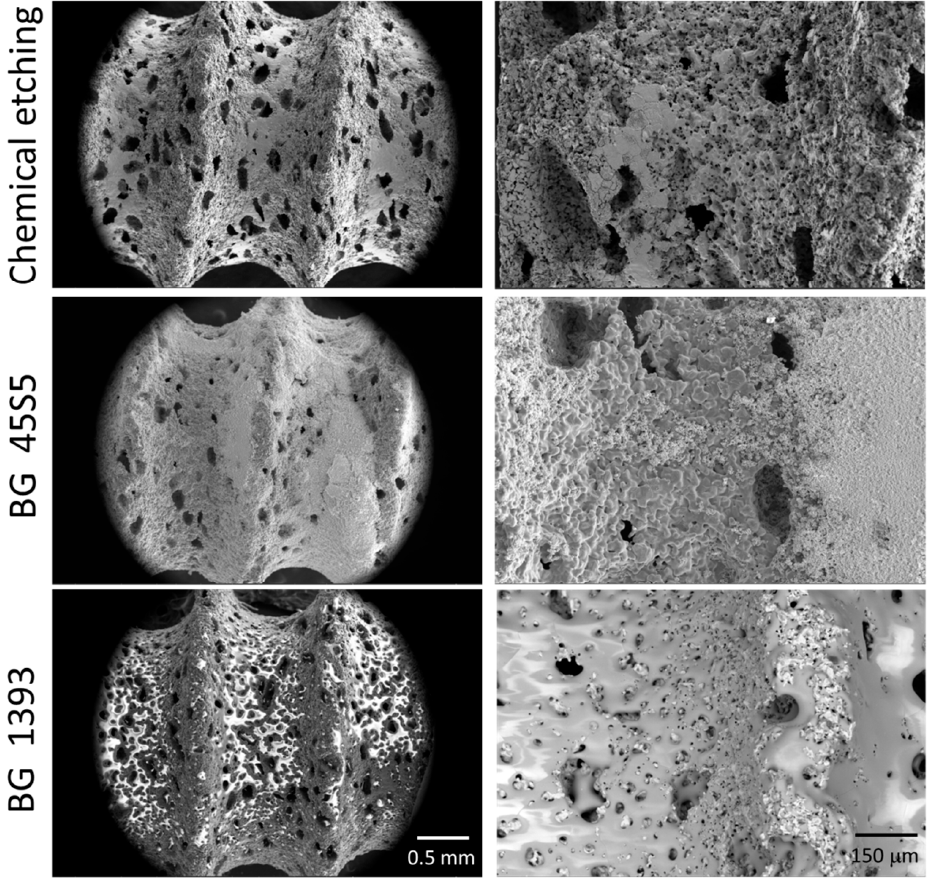
Figure 1. SEM image of the superficially treated porous dental implants.